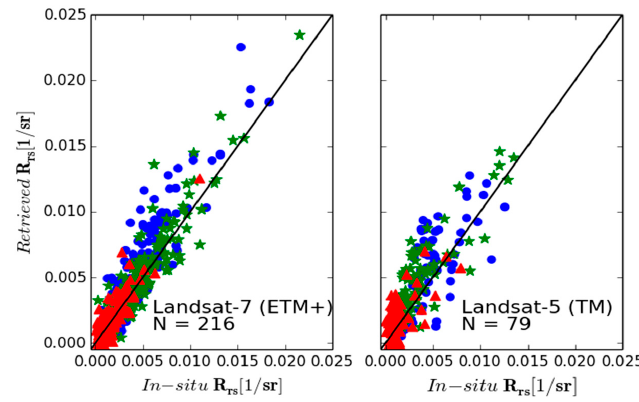
Figure 8. The scatterplots for TM and ETM+ matchups at AERONET-OC sites. The low median biases (Table 4) indicate that the final vicarious gains, on average, have enhanced the overall consistency of Landsat-derived products. The matchups exclude retrievals in areas with partial glints. The AERONET-OC matchups ( N = 216) enable a robust analysis of the ETM+ products, whereas the quality of TM products require further scrutiny (see Section 3.2.2).